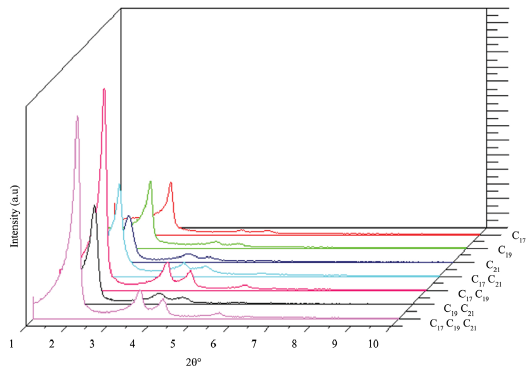
Figure 3. XRD pattern of C